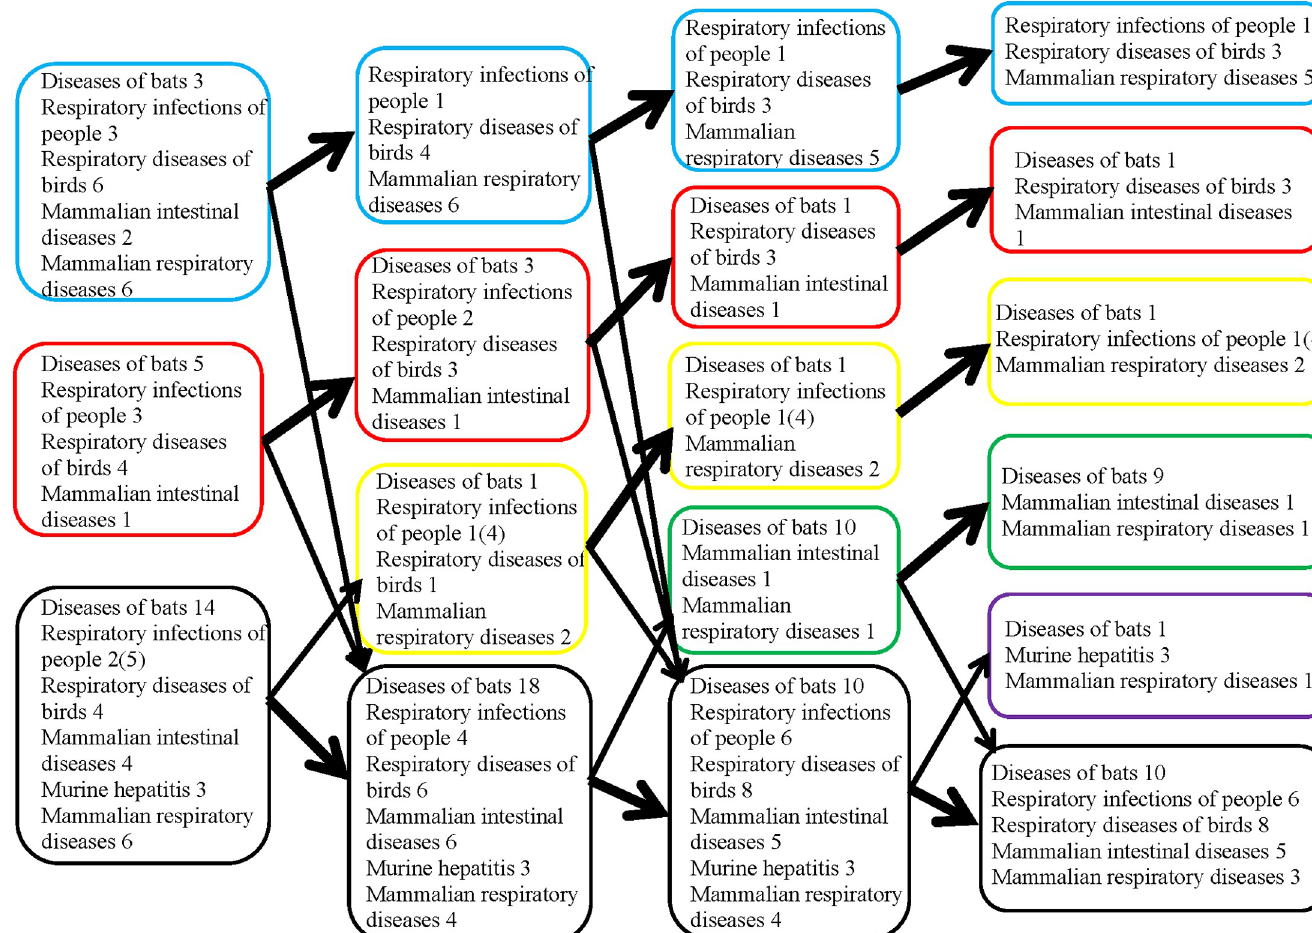
Fig 3. Results of the same step-by-step classification of 69 coronavirus genomes by K -means (from 2 to 5 classes) as in Fig 2 of the same viruses but named according to the type of disease that they cause. Boxes in a blue frame represents the 1 st class, red—2 nd class, yellow—3 rd , green—4 th , violet—5 th , black—unclassified volatile genomes, the position of which was unstable between